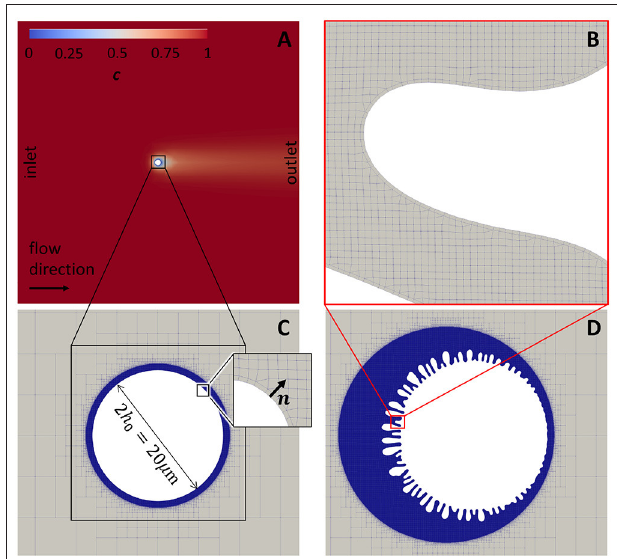
FIGURE 1 | The geometry and initial concentration distribution in the flow around a particle in two dimensional simulation domain. (A) Concentration distribution in a whole 2D simulation domain of 1 × 1 mm with a particle of radius 10 µ m at the center of the domain. (B) Mesh at the boundary between the meshed fluid domain and solid. (C) Meshed domain around the particle before precipitation (initial geometry). (D) Meshed domain around the particle after